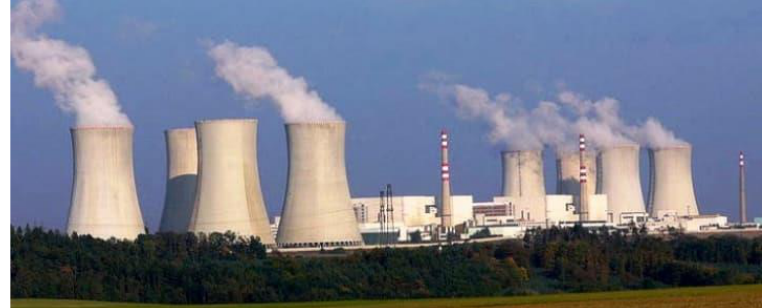
Figure 1. Nuclear plant.